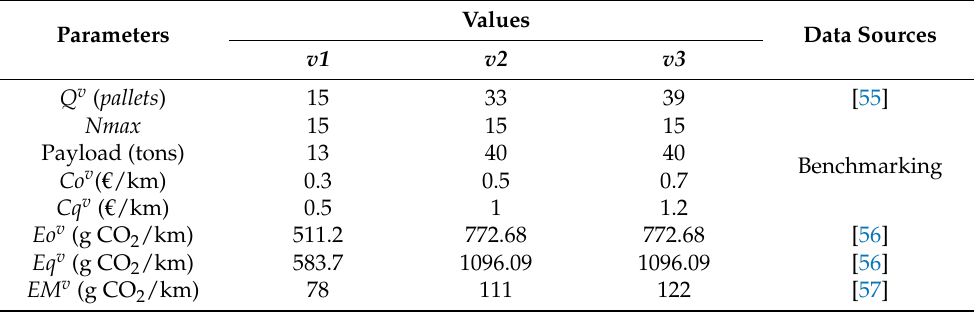
Table 2. The required data for the used vehicles.